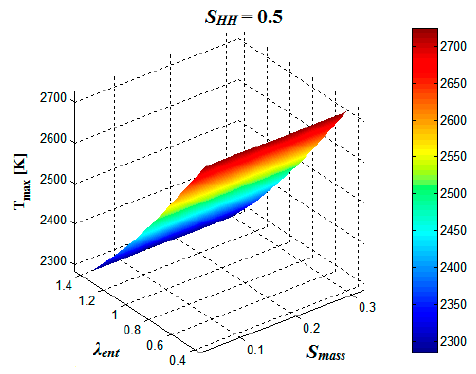
Figure 19. Peak pressure values when S HH is fixed.